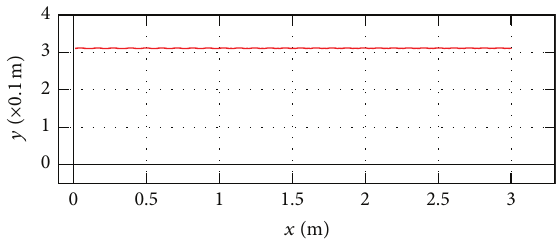
Figure 8: Trajectory of robot’s position.